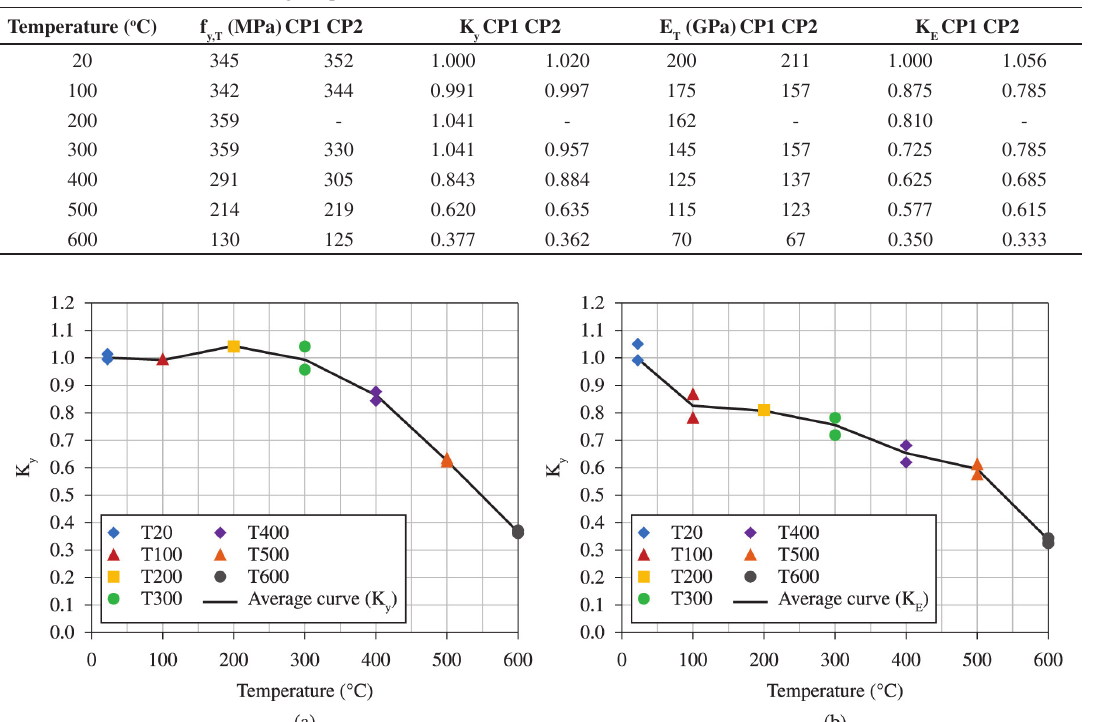
and (b) elastic y